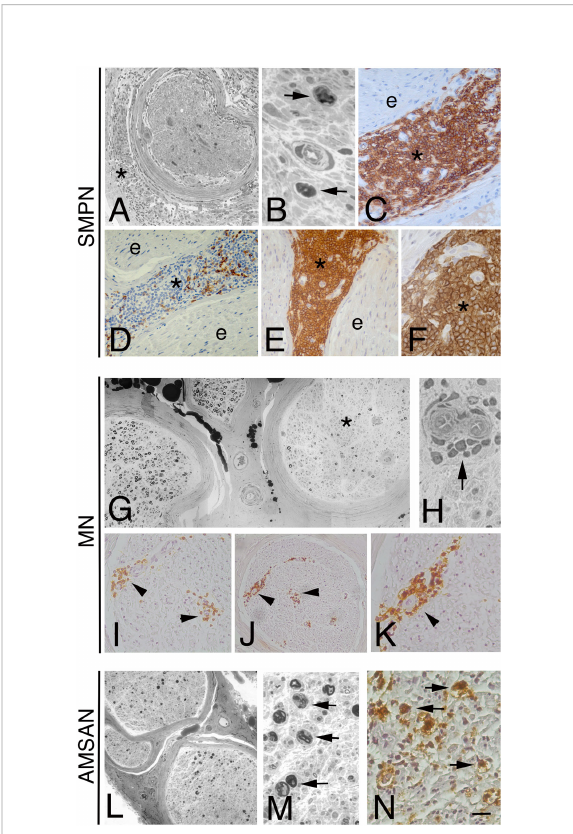
FIGURE 1 Representative neuropathological cases of NL. Transverse semi- thin sections of sural nerve from a sensorimotor peripheral neuropathy (SMPN) case ( A , B ): severe loss of myelinated fi bres is evident in a fascicle ( A ), surrounded by lymphomatous cells in epineurium ( A , asterisk); high magni fi cation shows myelin ovoids, indicating axonal degeneration ( B , arrows). LCA immunohistochemistry shows massive in fi ltration by large lymphoid cells in epineurium ( C , asterisk; e marks endoneurium); anti-CD3 antibody staining shows few positive cells in epineurium ( D , asterisk; e marks endoneurium). The majority of LCA positive cells display immunoreactivity for the CD20 B-cells marker in the epineurium (asterisk, E , F ; e marks endoneurium). (G-K) : epoxy and paraf fi n sections of a sural nerve from a patient with multiple mononeuropathy (MN). Semi-thin cross-section of nerve specimen showing a non-uniform fascicular reduction of myelinated fi bres, one fascicle is more severely affected ( G , asterisk) than others. Note atypical perivascular mononuclear cells in fi ltrate in the endoneurium ( H , arrow). Immunohistochemistry on paraf fi n section showed LCA-cells perivascular in fi ltrate in endoneurium ( I , arrowheads) that immunostain for CD20 B-cell marker ( J , K , arrowhead). Acute motor-sensory axonal neuropathy (AMSAN, L - N ): semi-thin sections of sural nerve show reduction of myelinated nerve fi bres (L) , without axonal regeneration. Axonal degeneration characterized by numerous myelin ovoids ( M , arrows). Immunohistochemistry shows massive cell in fi ltrate in the endoneurium by malignant B-cells (CD 20+) ( N , arrows). Scale bar represent 200µm ( A , D , E , G , I , J , L ); 50µm (K) ; 20µm (B, C, F, H, M, N)